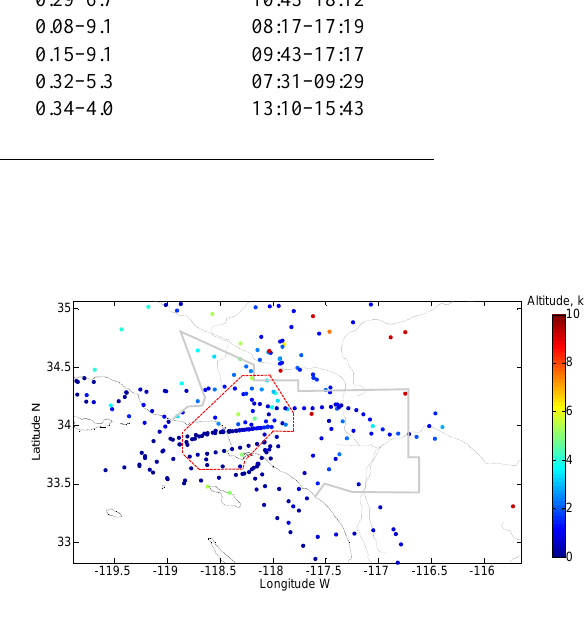
Figure 2. Geographic distribution of samples collected over Southern California. The SoCAB Fig. 2. Geographic distribution of samples collected over Southern is indicated by the solid grey line and samples obtained within the LA area are included California. The SoCAB is indicated by the solid grey line and sam- within the red dashed line. ples obtained within the LA area are included within the red dashed